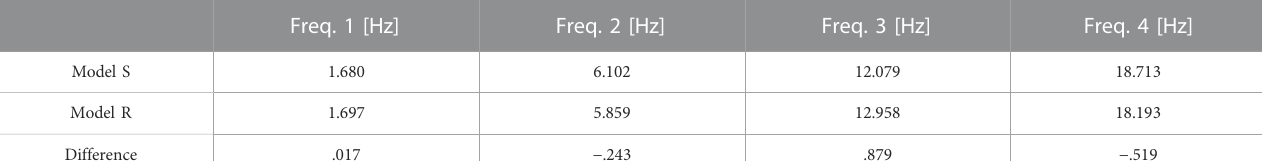
TABLE 1 Numerical case study: comparison between natural frequencies of model S and R after calibration.